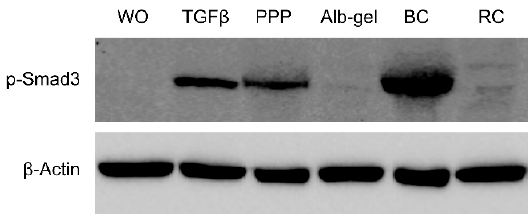
Figure 6. Lysates of PPP and the buffy coat layer but not heated PPP provoked phosphorylation of Smad3. Gingival fibroblasts were exposed for 1 h to 30% of the lysates prepared from PPP, heated PPP (Alb-gel) (75 °C for 10 min), and buffy coat (BC). For red clot (RC), 5% of the lysates was used. Western blot showed a strong increase in the basal Smad3 phosphorylation signal by lysates prepared from PPP and the buffy coat (BC) but not when cells are exposed to lysates of heated PPP and red clot.